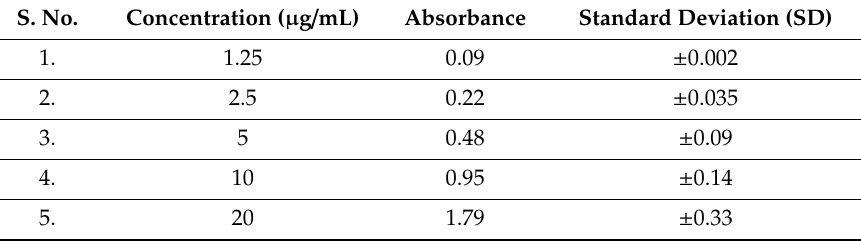
Table 2. Concentration vs. absorbance of